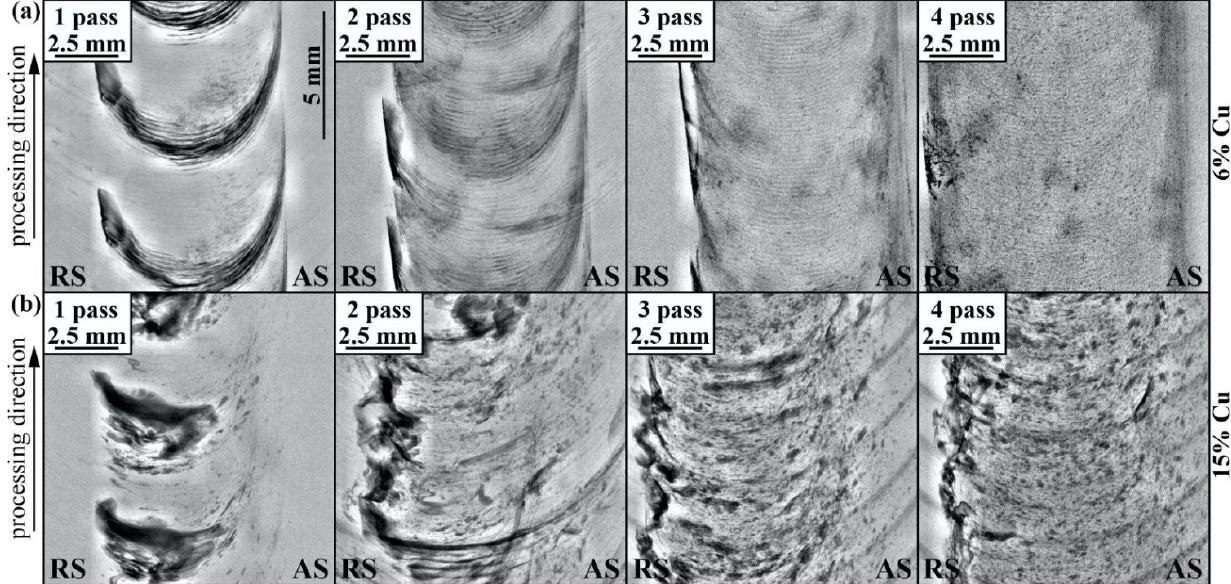
Figure 9. The enlarged X-ray computer tomography in-plane images of samples with 6 ( a ) and 15 vol.% ( b ) Cu obtained from samples with 1 to 4 passes after FSP.